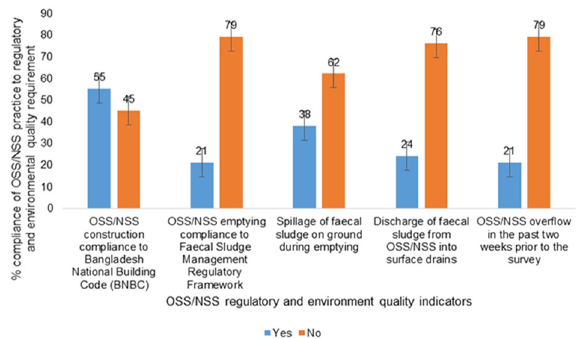
Fig. 4 Compliances rate of onsite sanitation systems/non-sewered sanitation systems (OSS/NSS) practices to regulatory and environmental quality requirements in Bangladesh. A facility survey and observation of 80 out of the 691 on-site sanitation systems in Khulna ward 9 were carried out to determine compliance to Bangladesh National Building Codes. 45% of the OSS/NSS survey did not comply to construction guidelines of national building codes; on 21% complied to emptying guidelines in faecal sludge management regulations; 62 percent were not in compliance to spillage of faecal matter during emptying procedures while only 24% showed no discharge to surface drains and 21% had no indications of over fl ow into the environment. In summary, most of the OSS/NSS survey were not in compliance to any regulations and had failed in several